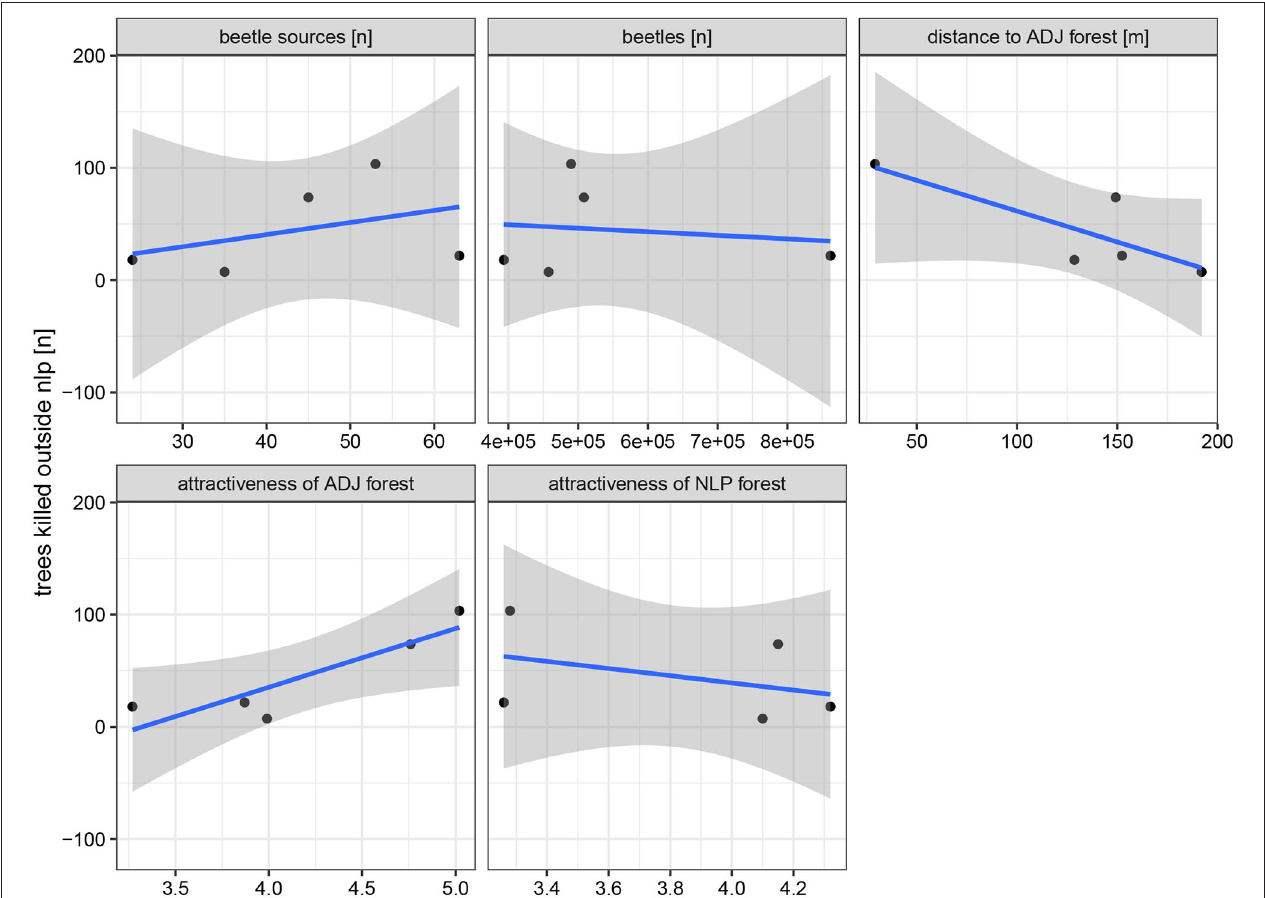
FIGURE 5 | Mean amount of damaged tress [n] outside the national park (NLP) for the control variants (no sanitation felling applied) of each research area. Each panel displays a different property (from top left to bottom right): Amount of beetle source trees, amount of emerging beetles during the first generation, distance between source trees and adjacent forest area (ADJ), mean primary attractiveness of ADJ and mean primary attractiveness of the NLP. Blue lines display a linear model fitted with the smooth function of the R package ggplot2 and gray areas highlight the 95% confidence